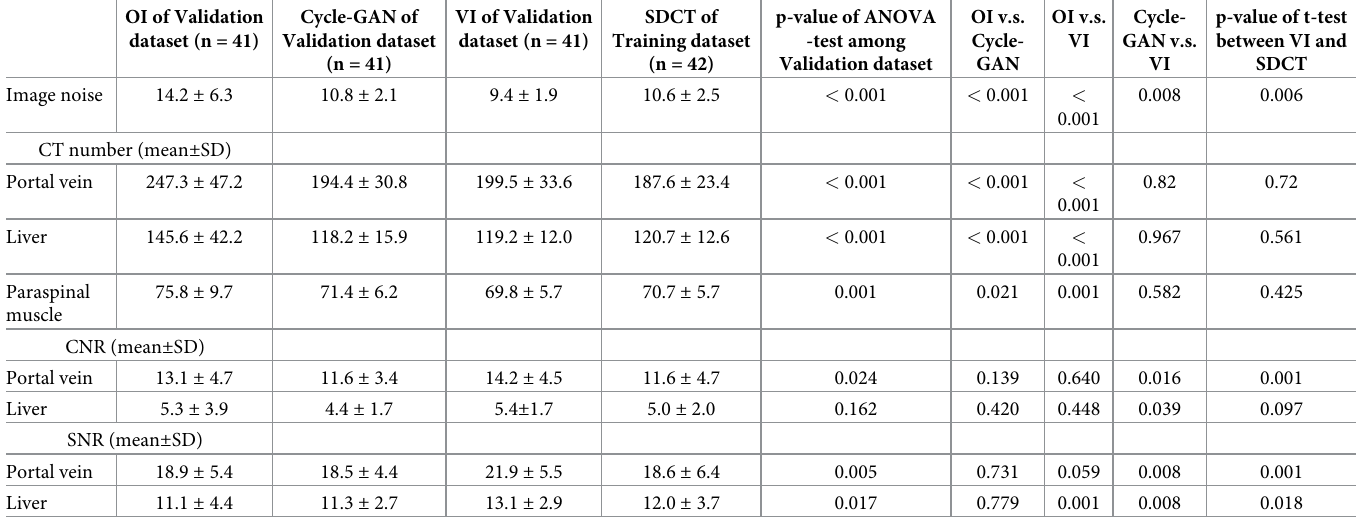
Table 2. Quantitative image analysis of training and validation dataset. OI of Validation dataset (n =